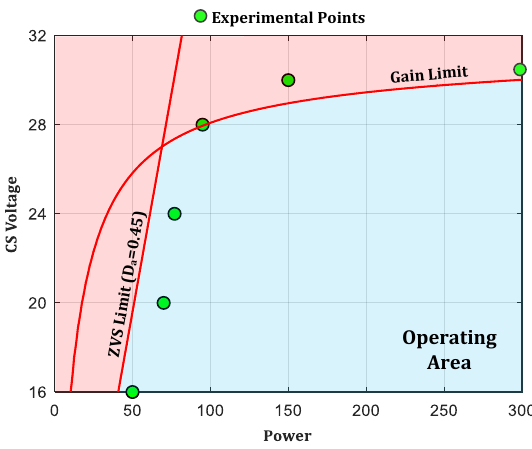
Figure 10. Theoretical and experimental operating boundaries.